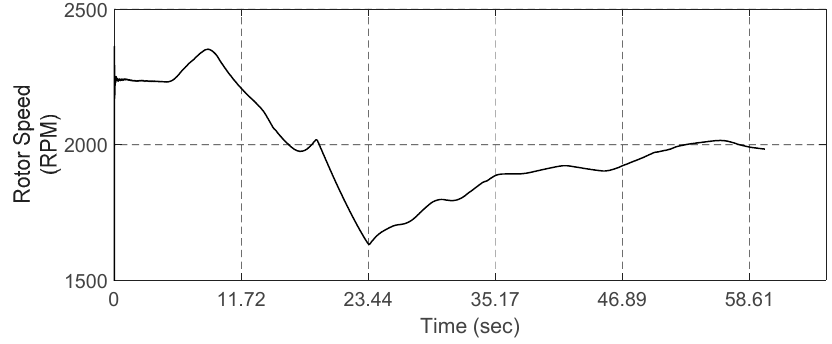
Figure 7. Variable speed environment, w r ∈ [1600, 2400] rpm.